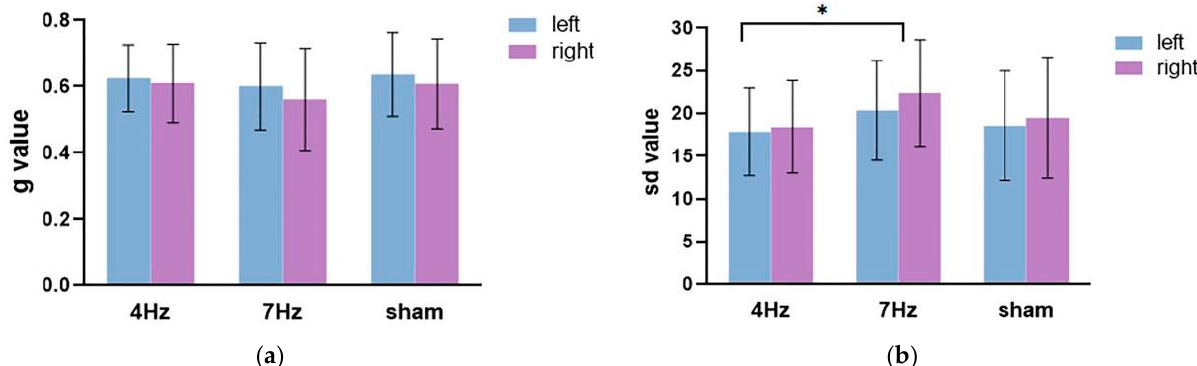
Figure 5. The results of the guess rate ( a ) and precision ( b ) in the three stimulation conditions (4 Hz/7 Hz/sham) for the low WMC group. The blue bar represents the left hemifield and the purple bar represents the right hemifield. Note that higher sd values imply a worse quality and higher g values mean a lower quantity of working memory.The asterisks (*) at the top of bar graph denote p < 0.05.